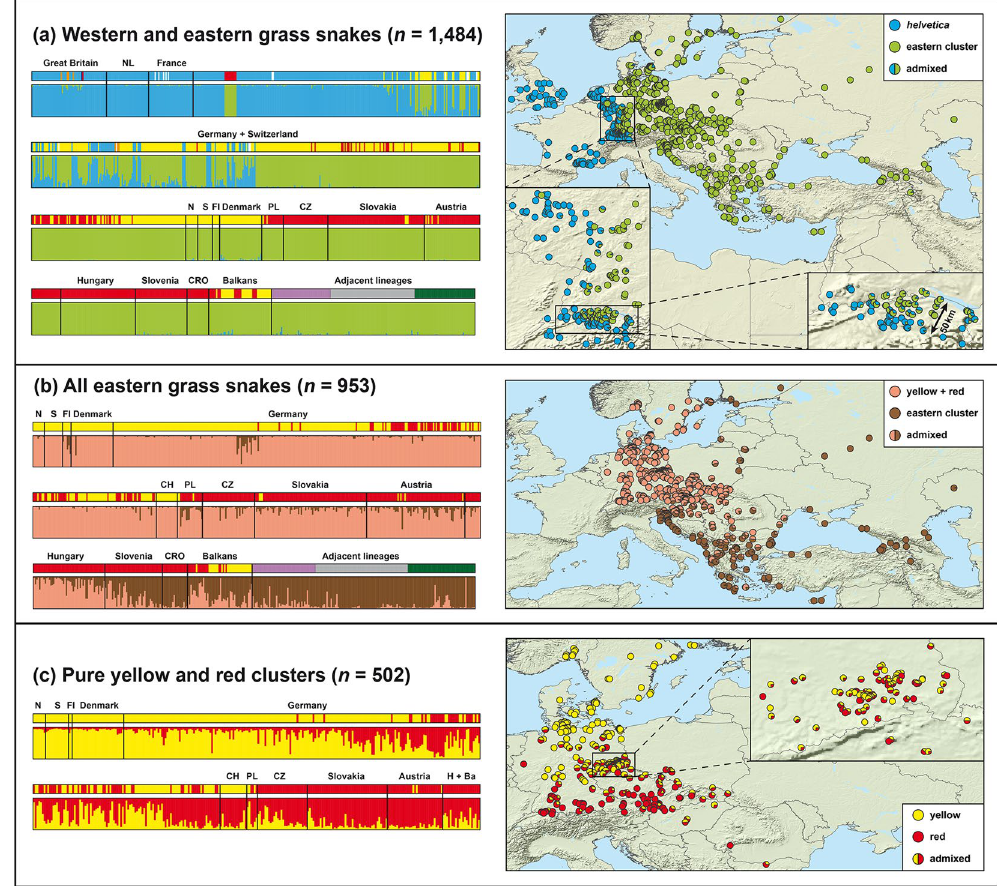
Figure 3. Genotypic structuring of grass snakes. On the left, the mitochondrial lineage of each sample is shown above the structure diagrams, with haplotypes of Natrix natrix helvetica indicated in blue and haplotypes of the eastern lineages in colours corresponding to Fig. 1 (yellow, red, lilac, grey, green; white = missing data). In ( a ), orange and dark blue corresponds to non-native snakes (Italian lineages). Samples in structure diagrams are arranged within each country from west to east ( a ) or from north to south ( b , c ). In structure diagrams, an individual sample is represented by a vertical bar reflecting its inferred ancestry. In ( a ), the blue cluster corresponds to N. n. helvetica and the light green cluster to all other lineages. The isolated red/light green block (first row) represents the allochthonous population from the Neander valley, Germany. In ( b ), samples with genetic impact of helvetica are excluded. The pink cluster corresponds to samples from the yellow and red lineages. Brown percentages indicate genetic impact of adjacent lineages (lilac, grey, green). In ( c ) only samples from the yellow and red lineages and their hybrids, without genetic signatures of other lineages, were processed. Country abbreviations: Ba – Balkans (Albania, Bosnia and Herzegovina, Montenegro, Serbia, Kosovo, Former Yugoslav Republic of Macedonia, Romania, Bulgaria, and Greece), CH – Switzerland, CRO – Croatia, CZ – Czech Republic, FI – Finland, H – Hungary, N – Norway, NL – Netherlands, PL – Poland, S – Sweden. Maps were created using arcgis 10.2 (http://www.esri.com/arcgis) and adobe illustrator CS6 (http://www.adobe. com/products/